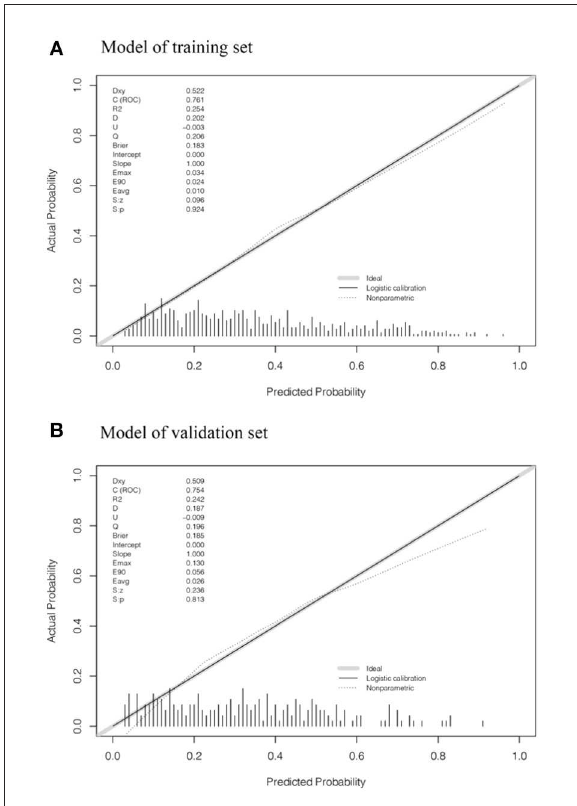
FIGURE4 Calibration plots of suicidal ideation in the training set and validation set. (A, B) showed the calibration plots of the training set and validation set, respectively. The x axis and y axis represent the predicted probability and actual probability of MSM with suicidal ideation, respectively. The diagonal gray solid line represents a perfect prediction by an ideal model. The dotted line represents the nonparametric calibration of the nomogram. The black solid line represents the logistic calibration of the nomogram, of which a closer fit to the diagonal gray line represents a better prediction.